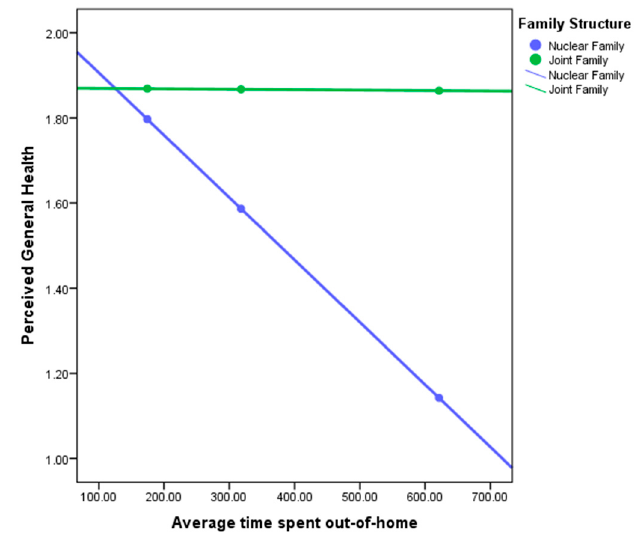
Figure 5. Perceived General Health with Average time spent out-of-home—Nuclear and multigenerational Family.